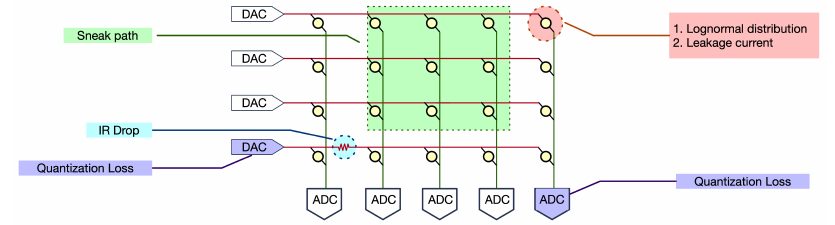
Figure 4. Noise overview in ReRAM